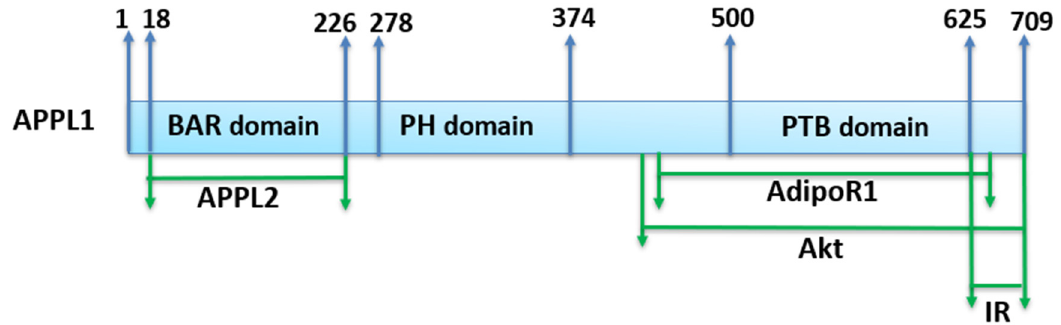
Figure 2. A broad APPL1 domain structure and binding sites of interaction proteins. The primary structure of APPL1, which consist of 709 amino acids, has a BAR (Bin1 / Amphiphysin / RVS167) domain, a PH (pleckstrin homology) domain, and a PTB (phosphotyrosine binding) domain. Broad sites of interacting proteins with APPL1 are labeled in green.